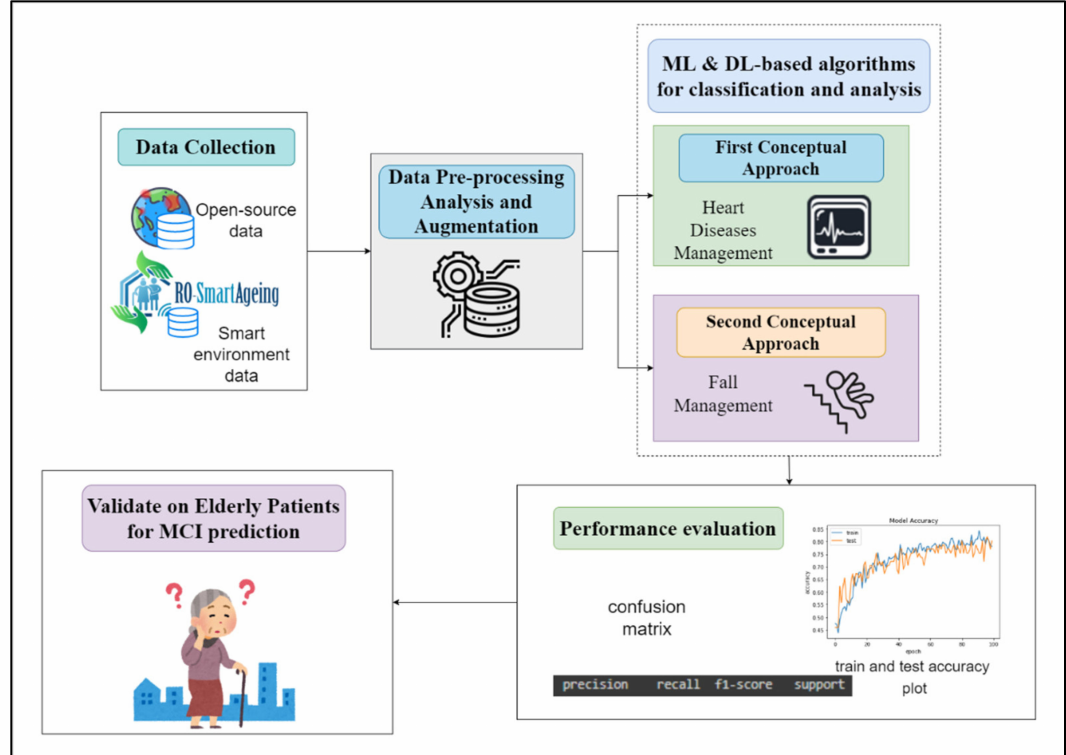
Figure 14. Proposed conceptual application for MCI prediction within RO-SmartAgeing